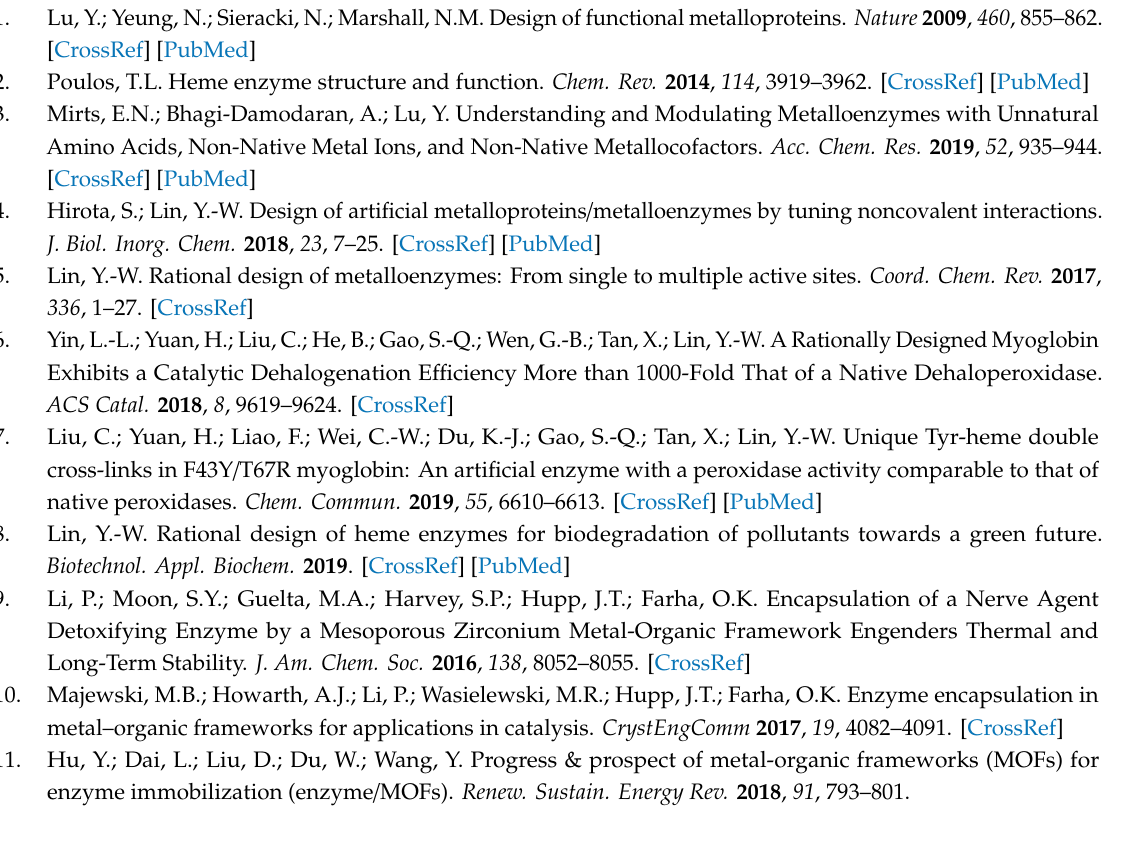
Figure S1: The preparation process of Cyt c @Cu(Im) 2 , and GOx-Cyt c @Cu(Im) 2 , Figure S2: UV-Vis spectra of free Cyt c before encapsulation (red) and the supernatant of Cyt c after encasing in Cu(Im) 2 (black), Figure S3: SEM images of the GOx@Cu(Im) 2 and GOx-Cyt c @Cu(Im) 2 , Figure S4: X-ray di ff raction (XRD) patterns of the Cu(Im) 2 , Cyt c @Cu(Im) 2 , GOx@Cu(Im) 2 , and GOx-Cyt c @Cu(Im) 2 , Figure S5: The e ff ect of pH on activity of (a) Cyt c and Cyt c @Cu(Im) 2 , (b) GOx-Cyt c, and GOx-Cyt c @Cu(Im) 2 , Figure S6: Relative activities of Cyt c @Cu(Im) 2 after water bath at 70 ◦ C and incubation in ethanol for 0.5